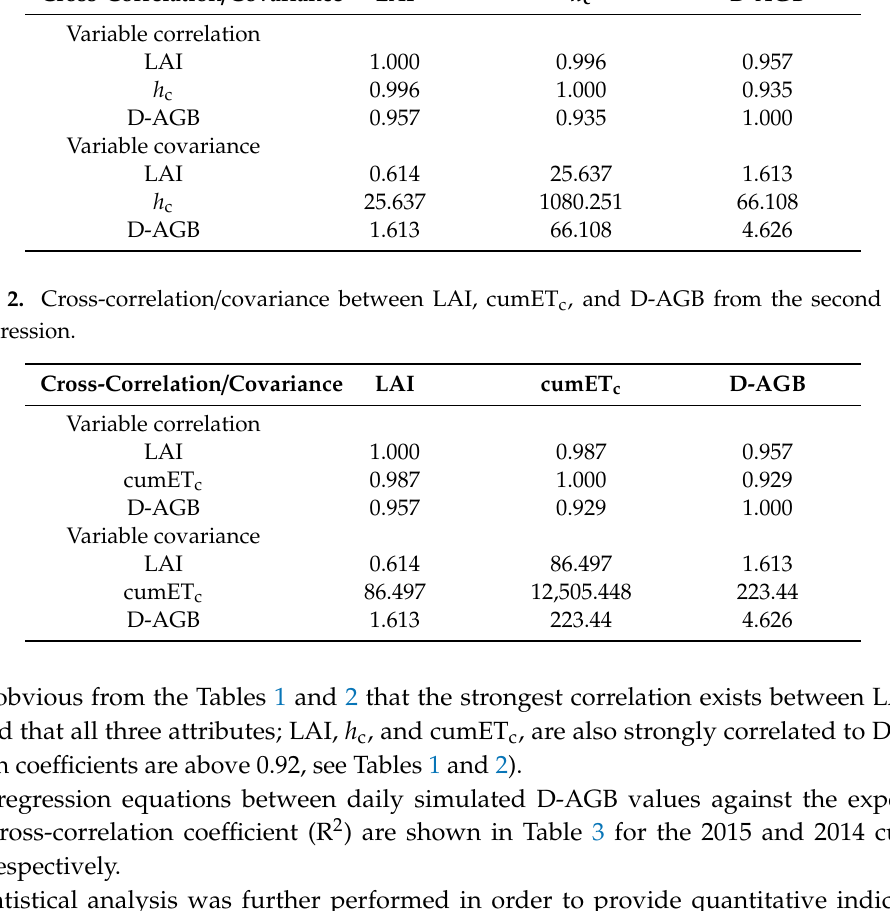
Table 1. Cross-correlation / covariance between LAI, h c , and D-AGB from the first stage of regression. Cross-Correlation / Covariance LAI h c Variable correlation